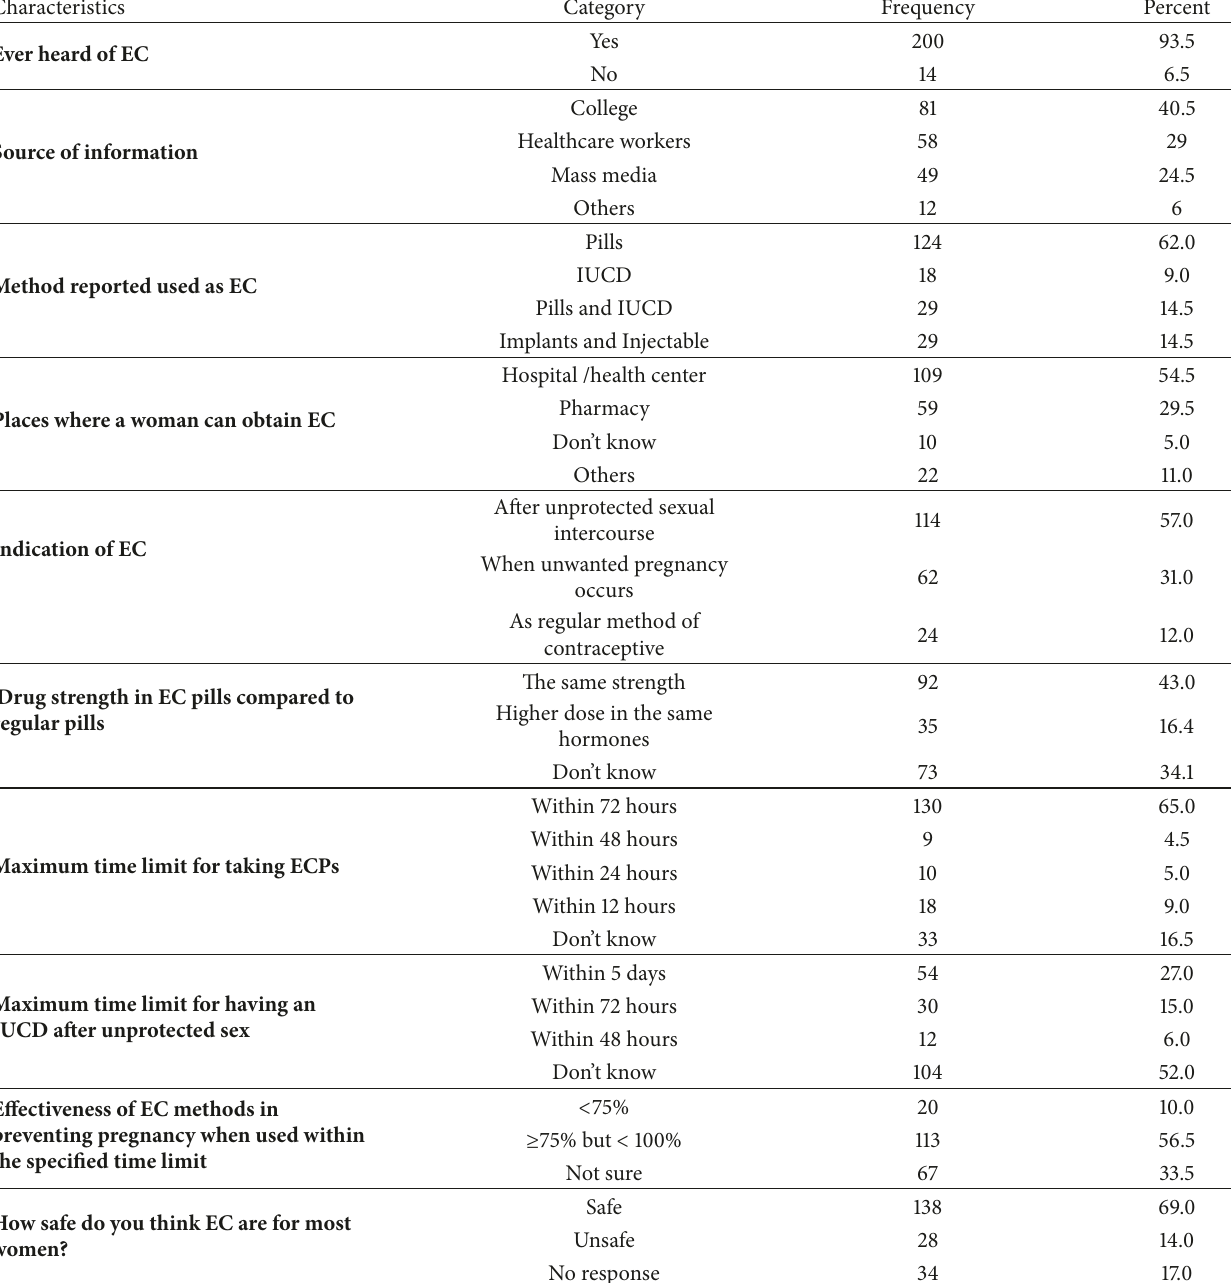
Table 2: Knowledge of emergency contraceptives among graduating female college students of Harar, eastern Ethiopia, 2016 (N=200).